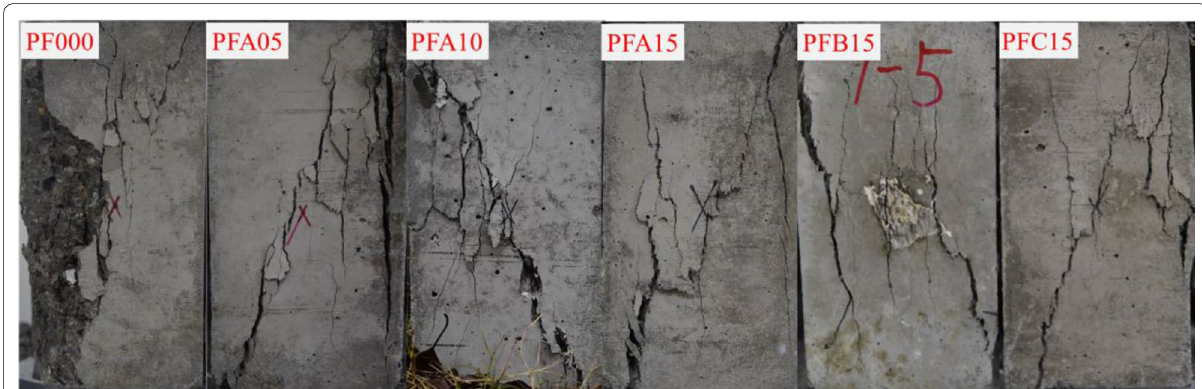
Fig. 3 Failure pattern of concrete